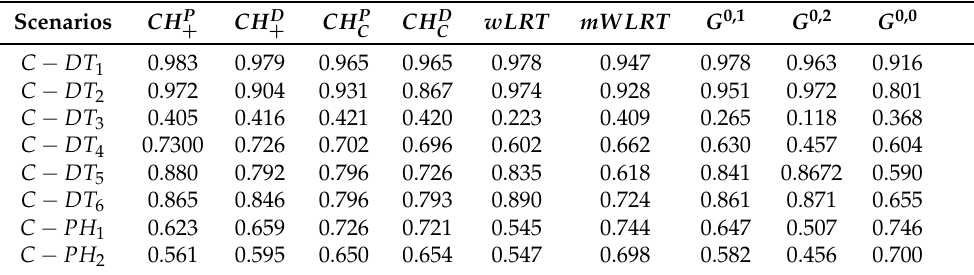
Table 6. Empirical power in clinical trial